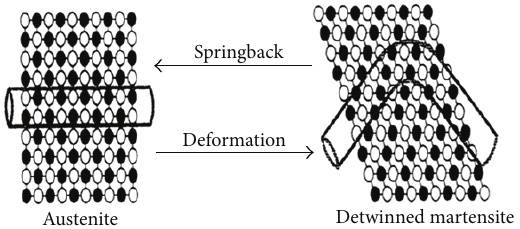
Figure 2: Diagrammatic representation of the superelasticity effect of NiTi alloy. Source: [33].